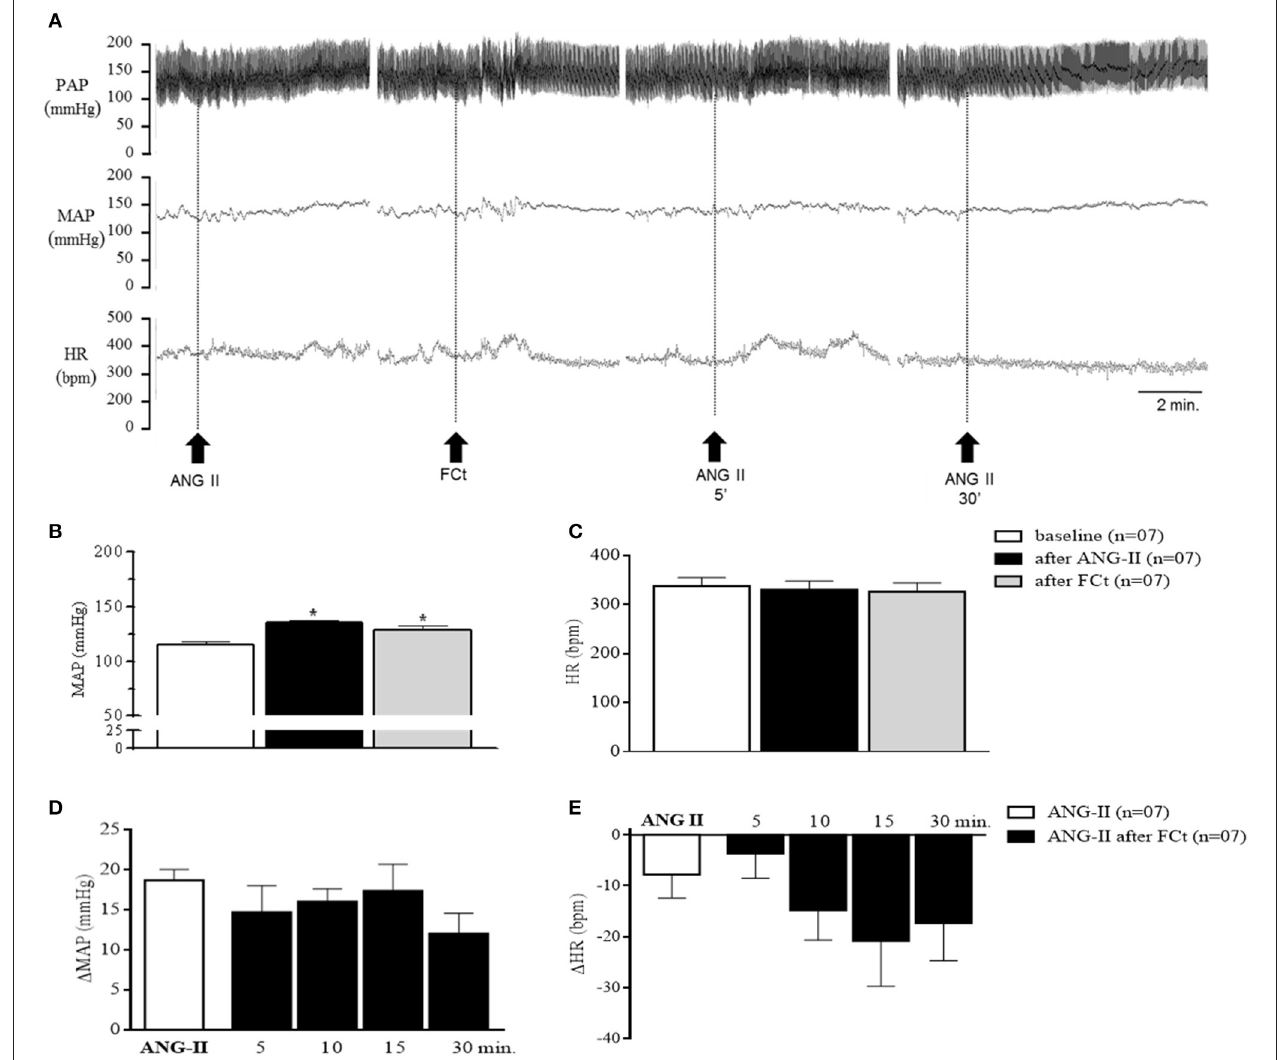
FIGURE 4 | Effect of icv ANG-II or FCt microinjection on baseline cardiovascular parameters. (A) Representative tracings of one rat showing changes in pulsatile arterial pressure (PAP, mmHg), mean arterial pressure (MAP, mmHg), and baseline heart rate (HR, bpm) induced by icv ANG-II before and 5 and 30min after FCt pretreatment. Arrows indicate icv ANG-II or FCt microinjections. (B,C) Changes in baseline MAP and (B) heart rate (C) before and after icv microinjection of ANG-II or FCt. (D,E) changes in MAP (D) and HR (E) to icv microinjection of ANG-II before and 5, 10, 15, and 30min after local FCt pretreatment in awake rats. Differences among groups were calculated by One-Way ANOVA followed by the Newman–Keuls post test. Values were expressed as means ± SEM. * p < 0.05 vs. control.